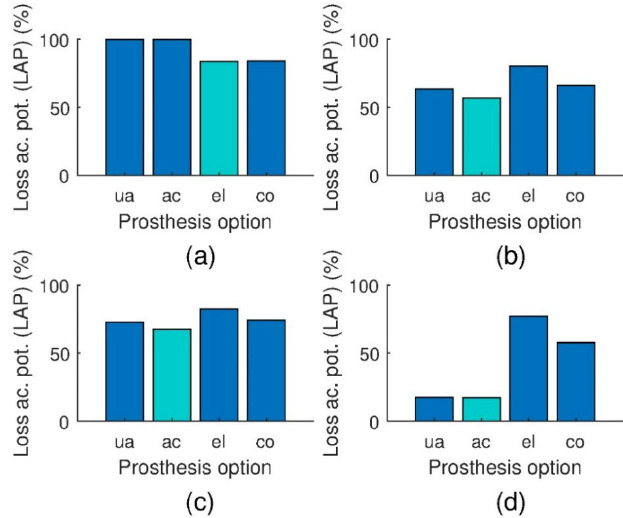
Figure 8. Bar charts of the cost-adjusted loss of action potentials (LAP). Four cases selected for detailed analysis, i.e., the cases reported in Figures 4–7. The bar charts ( a – d ) reflect for each of the four subjects personalized predictions of LAP with regard to the hearing prosthesis options. The shortest bars in each of ( a – d ) reflect the recommended hearing prosthesis option. Their colors are made distinct. The bar charts may be displayed to clinicians as personalized recommendation charts. They provide a concise overview of the prosthesis options, enabling quick judgement of absolute and relative bar heights. Unaided hearing (ua), sole acoustical amplification (ac), sole electrical stimulation (el), and electric stimulation combined with acoustical amplification (co).